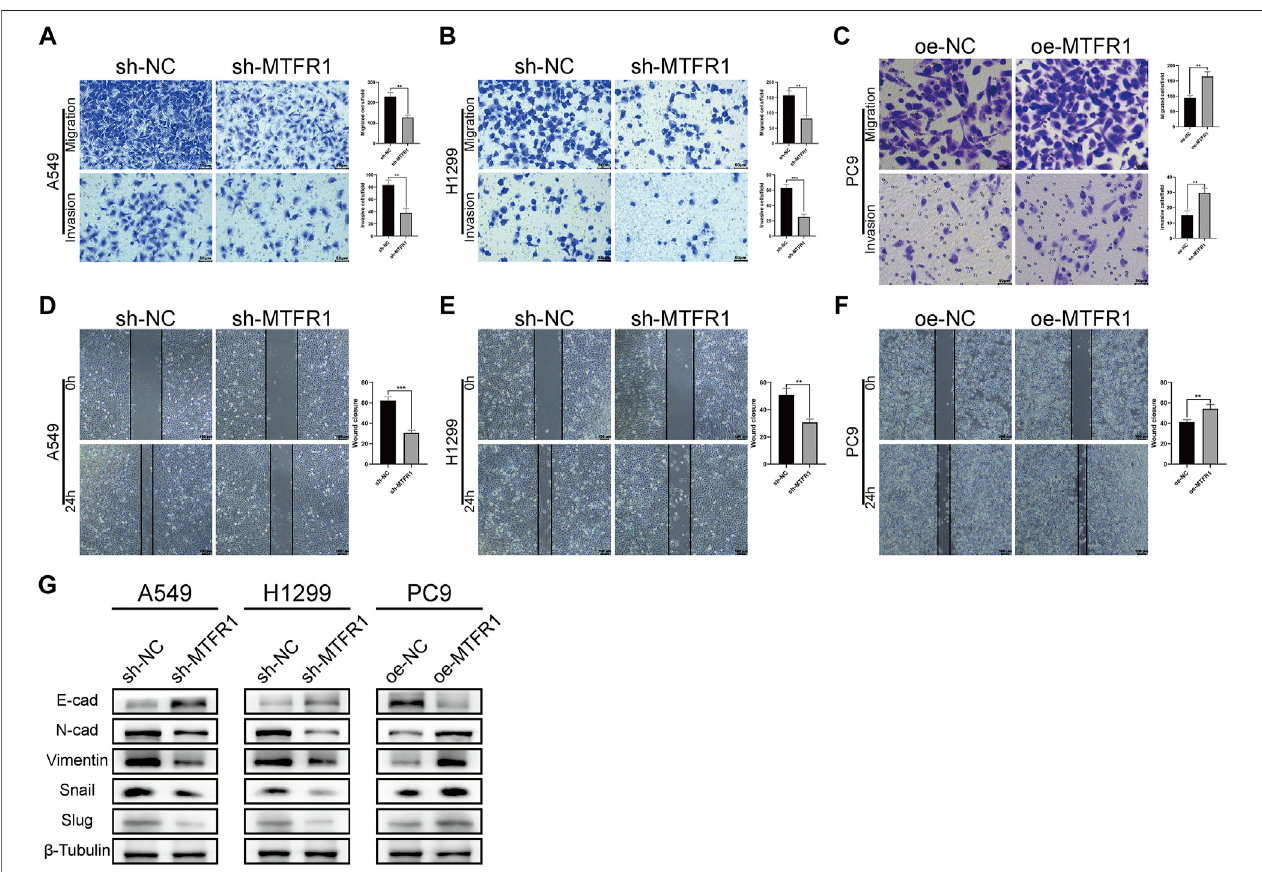
FIGURE 4 | (A – F) Evaluation of the invasion and migration abilities of transduced cells by Transwell and wound-healing assays. (G) Evaluation of the levels of epithelial – mesenchymal transition (EMT)-related proteins by WB. Data were articulated as the mean ± standard deviation (SD; ** p < 0.01 *** p < 0.001).